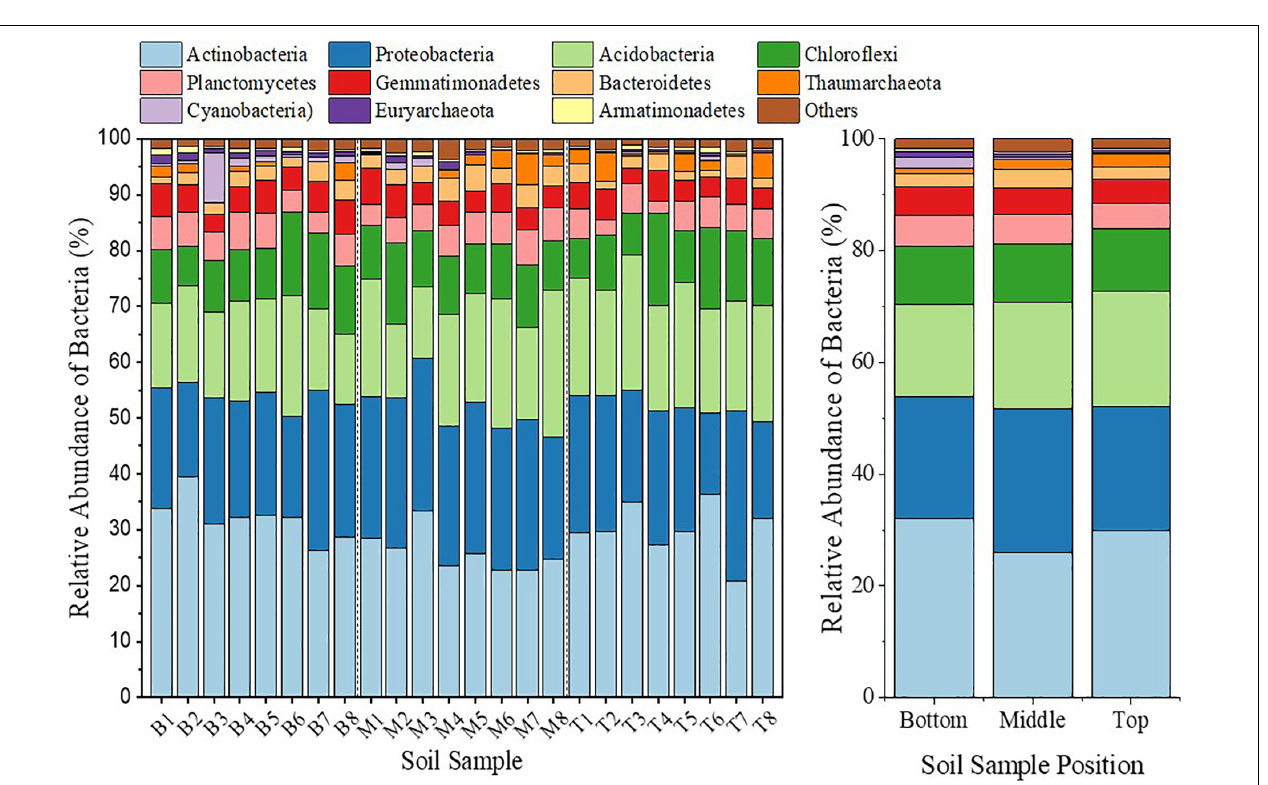
FIGURE 5 | Bar diagram to represent the bacterial community analysis on the phylum level at different locations of the subsidence area.